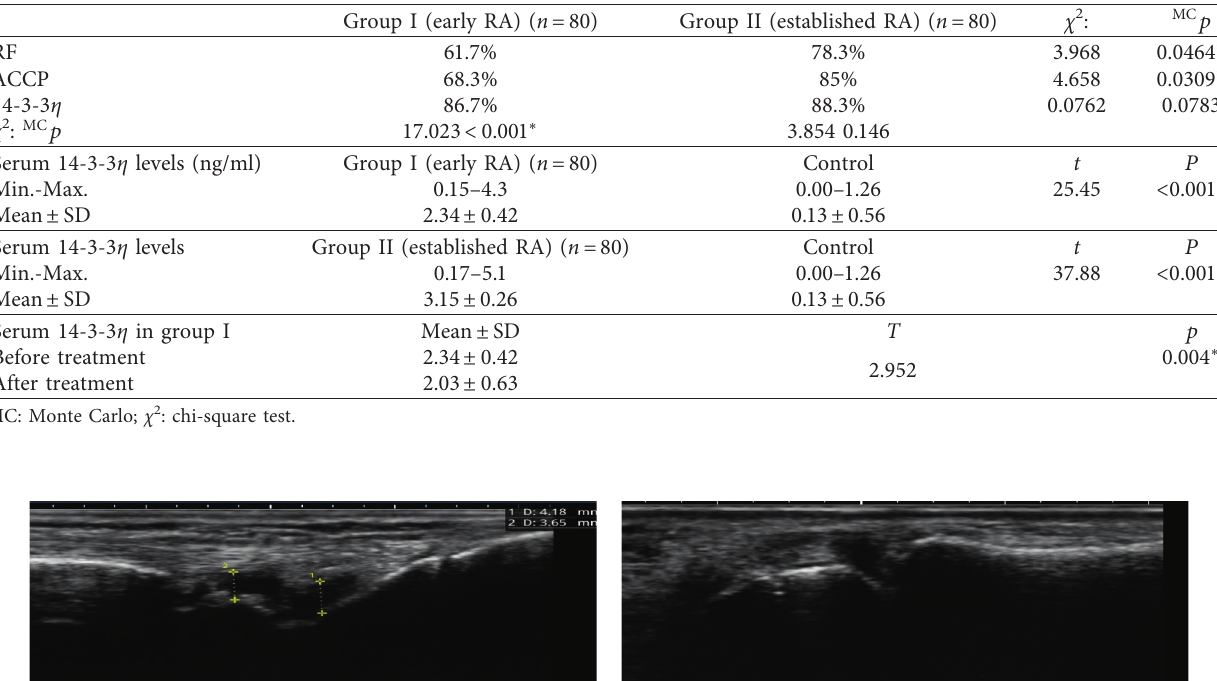
Table 1: A comparison of the sensitivity of various RA biomarkers in patients with early and established disease. Serum 14-3-3 levels (ng/ml) were compared between the two RA groups, as well as the control and comparison of serum 14-3-3 levels before and after anti-TNF therapy in group I patients.